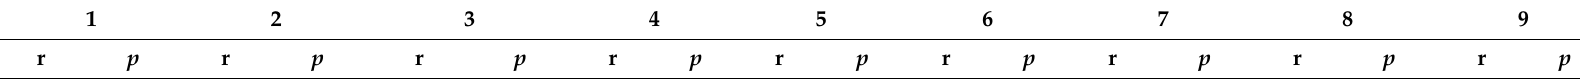
Table A5. Correlation analysis with Pearson’s r coefficient. Source: Own study.